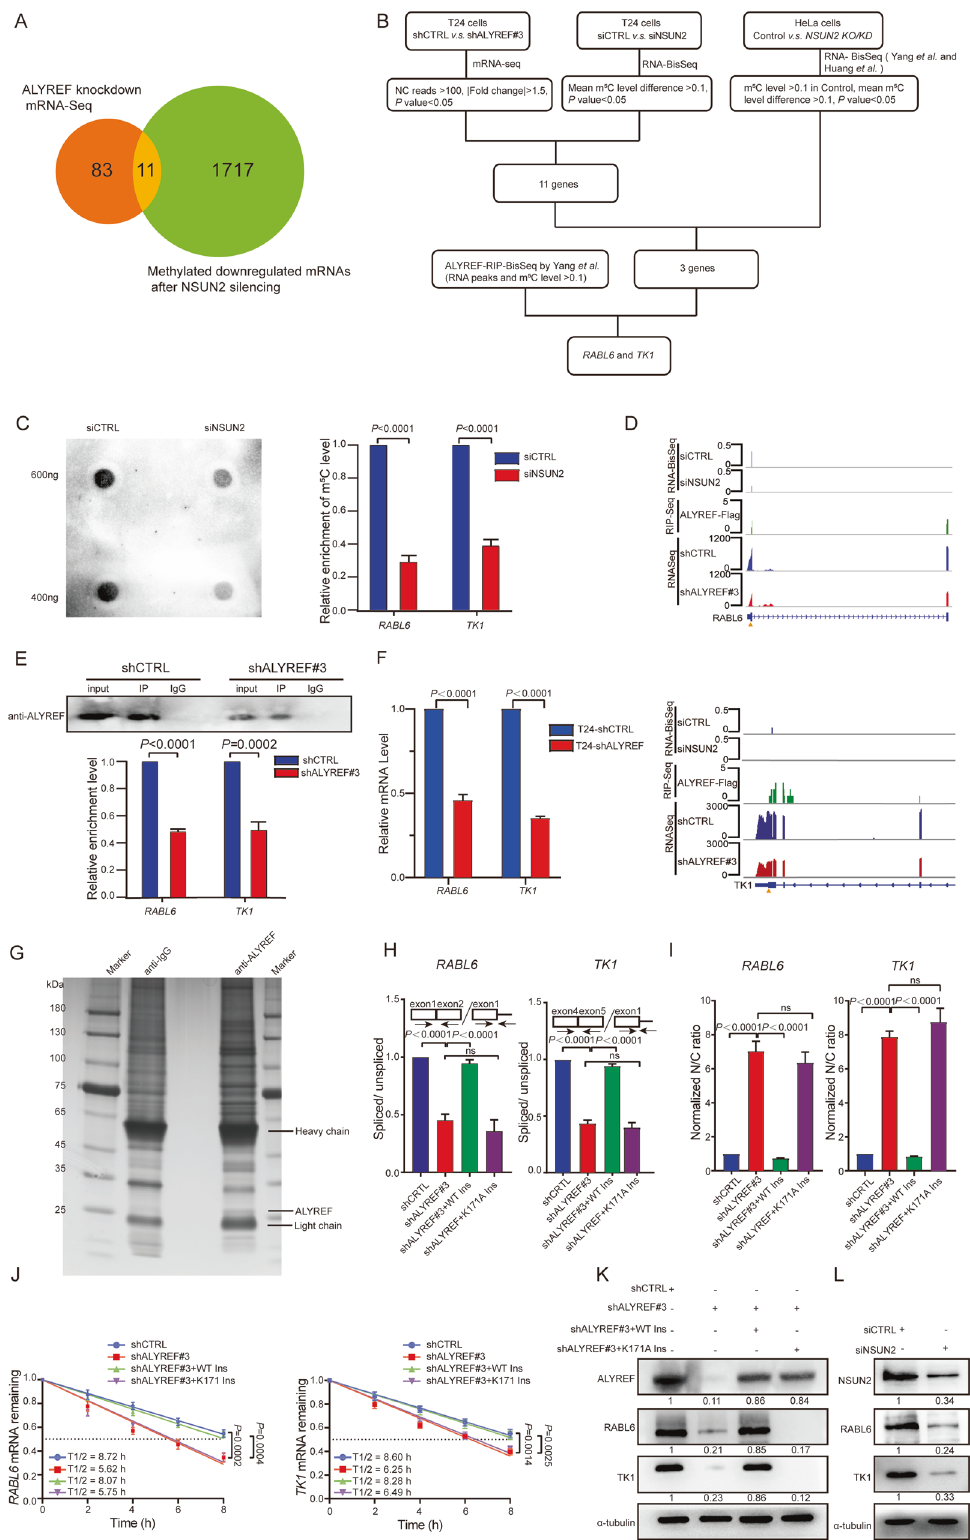
mRNA, exon-exon pair ampli fi es mature form mRNA. After knockdown of ALYREF, the splicing ef fi ciency of RABL6 and TK1 was signi fi cantly decreased as measured by the ratio of